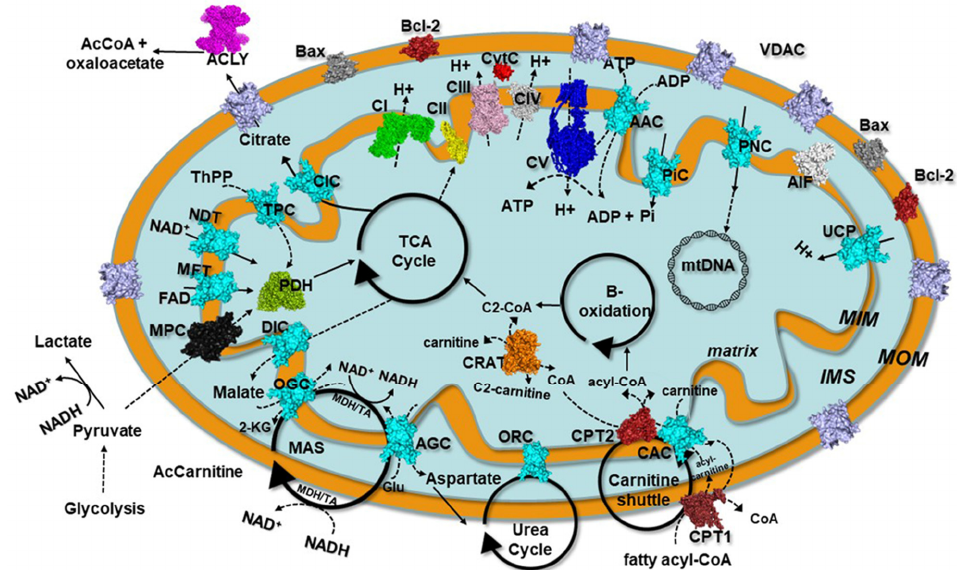
Figure 2. Scheme of a mitochondrion with a set of representative proteins, pathways and cycles. Respiratory chain complexes, mitochondrial transporters and other proteins are reported in surf representation and labeled. ATP synthase (CV) is reported in blue. Mitochondrial carriers are re- ported in cyan. VDAC is reported in pink. Bax and Bak/Bcl-2 are reported in dark grey and firebrick, respectively. MPC is reported in black. Complex I (CI), complex II (CII), complex III (CIII) and com- plex IV (CIV) are reported in green, yellow, magenta and grey, respectively. Black circular arrows indicate cyclic pathways. Red arrows indicate impaired pathways or reactions. Black solid/dashed lines indicate the possible direction of the reported reactions. Abbreviations: MIM: mitochondrial inner membrane; MOM, mitochondrial outer membrane; IMS, intermembrane space; AAC, ADP/ATP carrier, coded in H. sapiens by SLC25A4, SLC25A5, SLC25A6, SLC25A31; TPC, thiamine pyrophosphate carrier, coded by SLC25A19; CAC, carnitine/acyl-carnitine carrier, coded by SLC25A20; ORC, ornithine carrier, coded by SLC25A15 (or SLC25A2); AGC, aspartate/glutamate carrier, coded by SLC25A12 and SLC25A13; DIC, dicarboxylate carrier, coded by SLC25A10; NDT, assumed to be the NAD+ carrier, coded by SLC25A51; MFT, assumed to be the FAD (folate/ribofla- vin) carrier, coded by SLC25A32; OGC, malate/2-oxoglutarate carrier, coded by SLC25A11; CIC, citrate carrier, coded by SLC25A1; PiC, phosphate carrier, coded by SLC25A3; MAS, malate/aspar- tate shuttle; TCA, tricarboxylic acid cycle; Bax, Bcl-2 associated X protein; Bak, Bcl-2 antago- nist/killer-1; Bcl-2, B-cell lymphoma-2; MPC, mitochondrial pyruvate carrier; UCP, uncoupling pro- tein, coded by SLC25A7, SLC25A8, SLC25A9, SLC25A14, SLC25A27 and SLC25A30; CypD, cyclo- philin D; CytC, cytochrome C; VDAC, voltage-dependent anion channel; AIF, apoptosis-inducing